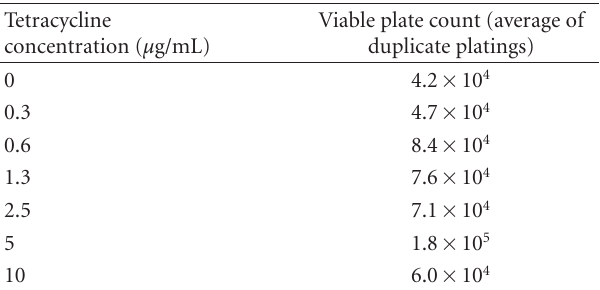
Table 1: E ff ect of tetracycline in YNB on growth of strain 142 at 6 hours (37 ◦